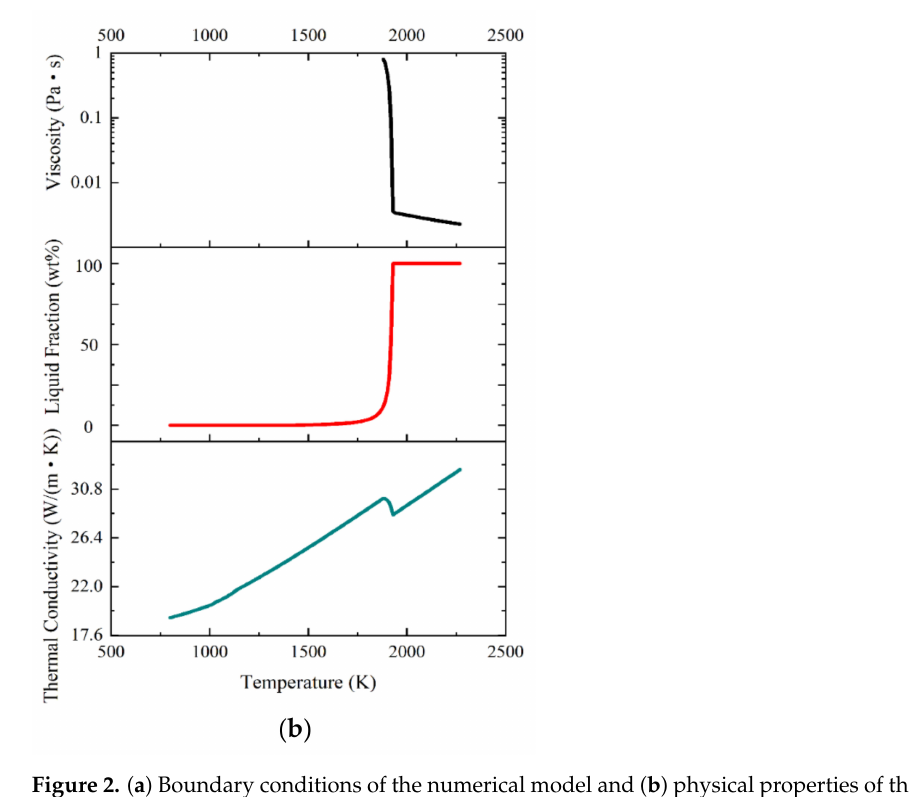
Figure 2. ( a ) Boundary conditions of the numerical model and ( b ) physical properties of the Ti-0.3Mo- 0.8Ni alloy used in the